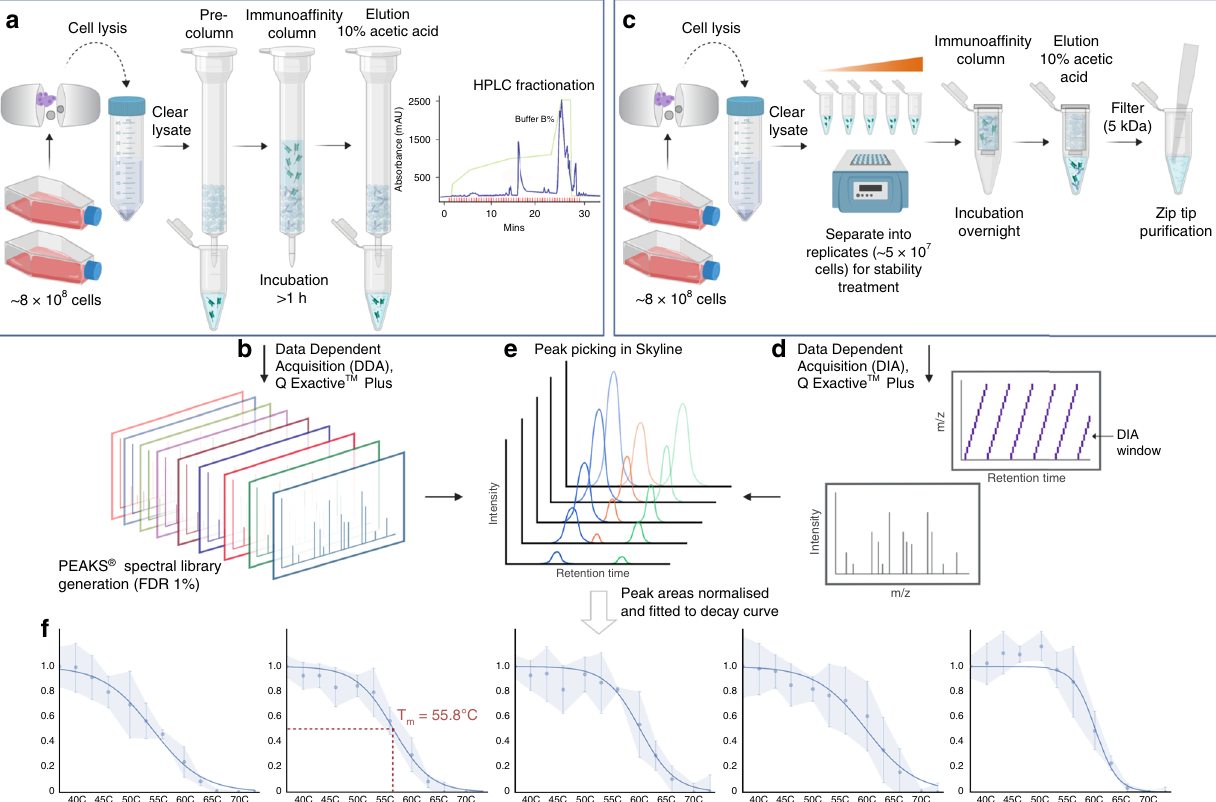
Fig. 1 Work fl ow for stability pro fi ling of HLA-associated peptides. a Initially, immunoprecipitation on C1R cells expressing the HLA allele of interest was carried out by culturing cells, lysing them, clearing the lysate, and isolating peptides according to established work fl ows 9 . b Liquid chromatography-tandem mass spectrometry (LC-MS/MS) analysis of pHLA eluates was performed in DDA mode to create HLA allele-speci fi c spectral libraries. c Small-scale immunoprecipitation was carried out by clearing lysates and separating these into replicates consisting of 5 × 10 7 cells, after which aliquots were incubated in triplicate at temperatures ranging from 37 to 73 °C with a temperature step-size of 3-4 °C. d Subsequently, the remaining thermostable HLA-bound peptides were eluted, fi ltered, and analyzed using a DIA strategy to enable peptide quanti fi cation at different temperature points. e Spectral library matching and fi ltering were performed in Skyline. f Peptide peak areas for triplicate samples were normalized and fi tted to sigmoidal decay curves to determine the temperature at which half of the complex was unfolded, termed the thermal melting temperature ( T m ). Thermal treatment of C1R cell lysates was carried out at 12 different temperature points ranging from 37 to 73 °C with n = 3 biological replicates at each temperature point. Data are presented as median values ± SD. FDR: False Discovery Rate. Parts of the fi gure were generated using